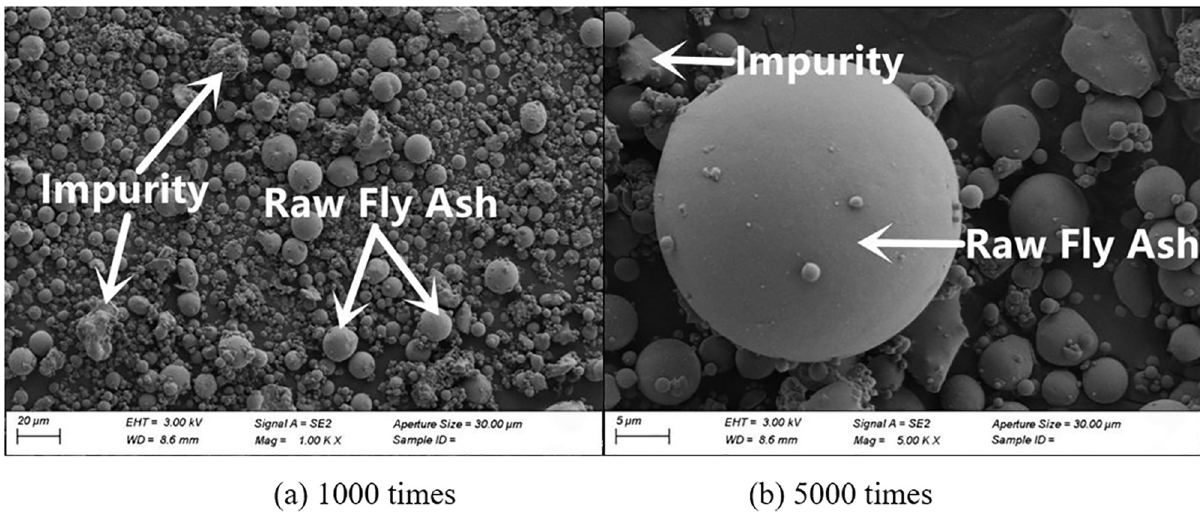
Fig 7. Fly ash microstructure before grinding.